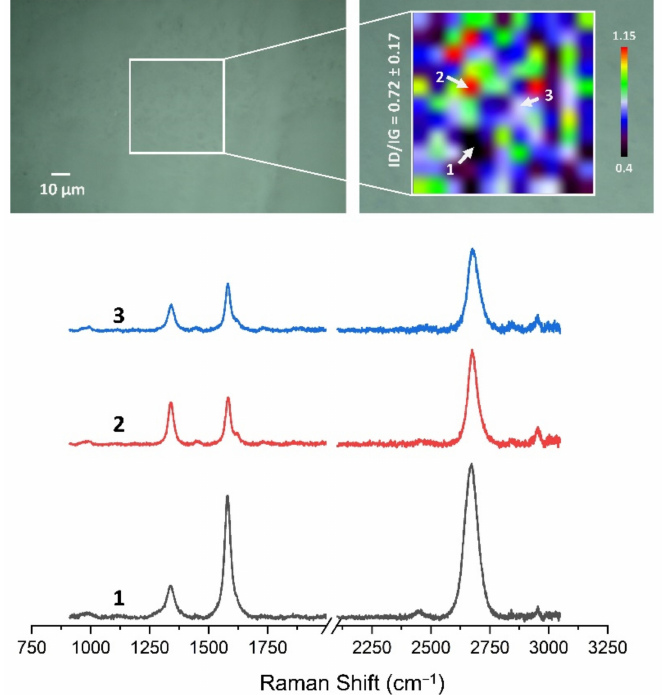
Figure 13. The Raman map and spectra of HSMG ® graphene transferred onto Al 2 O 3 ceramic substrates modified by DBD plasma.